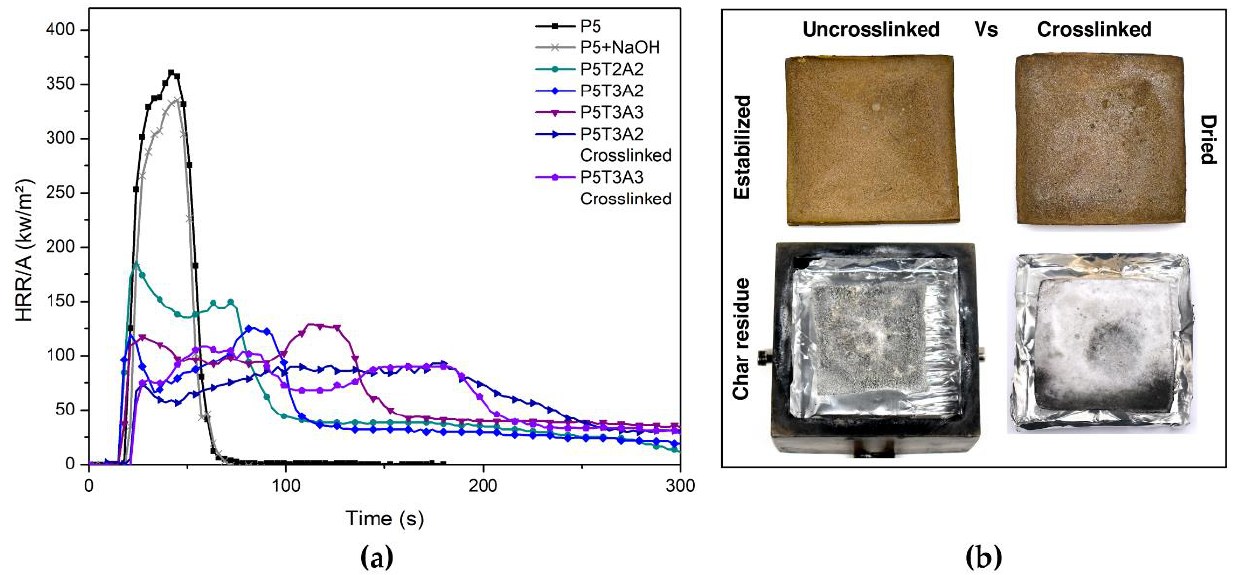
Figure 7. ( a ) Main representative HRR curves from uncrosslinked and crosslinked PVA/TA/SA aerogels; ( b ) digital photographs from P5T3A3 uncrosslinked and crosslinked aerogels before and after combustion at 50 kW/m 2 . Table 5. Cone calorimeter parameters for the different aerogels under study. Crosslinked samples were tested in a dry state. Uncrosslinked samples were tested after stabilization at 25 °C and 50% RH.